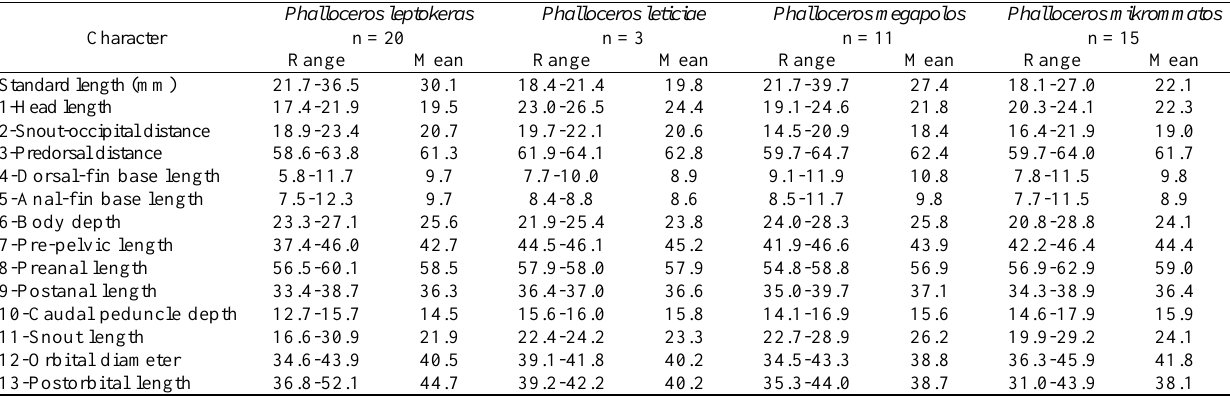
Table 1. Descriptive morphometrics of female specimens of Phalloceros leptokeras , P . leticiae, P . megapolo s, and P . mikrommatos . Measurements 1-10 are percents of standard length and measurements 11-13 are percents of head